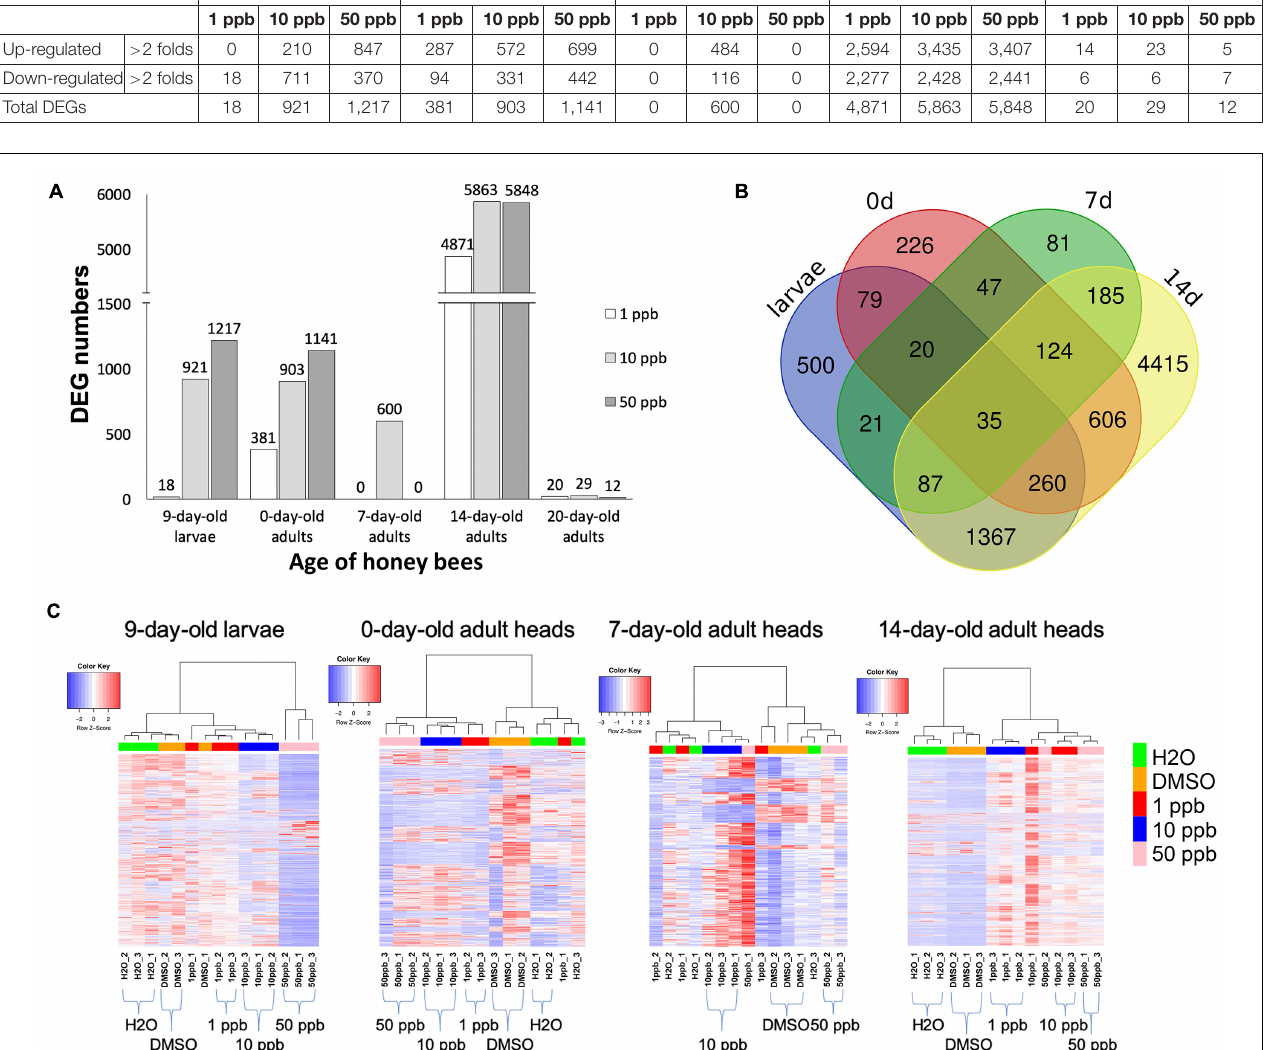
TABLE 1 | DEG numbers in different stages of honey bee fed with different concentrations of imidacloprid. Fold change